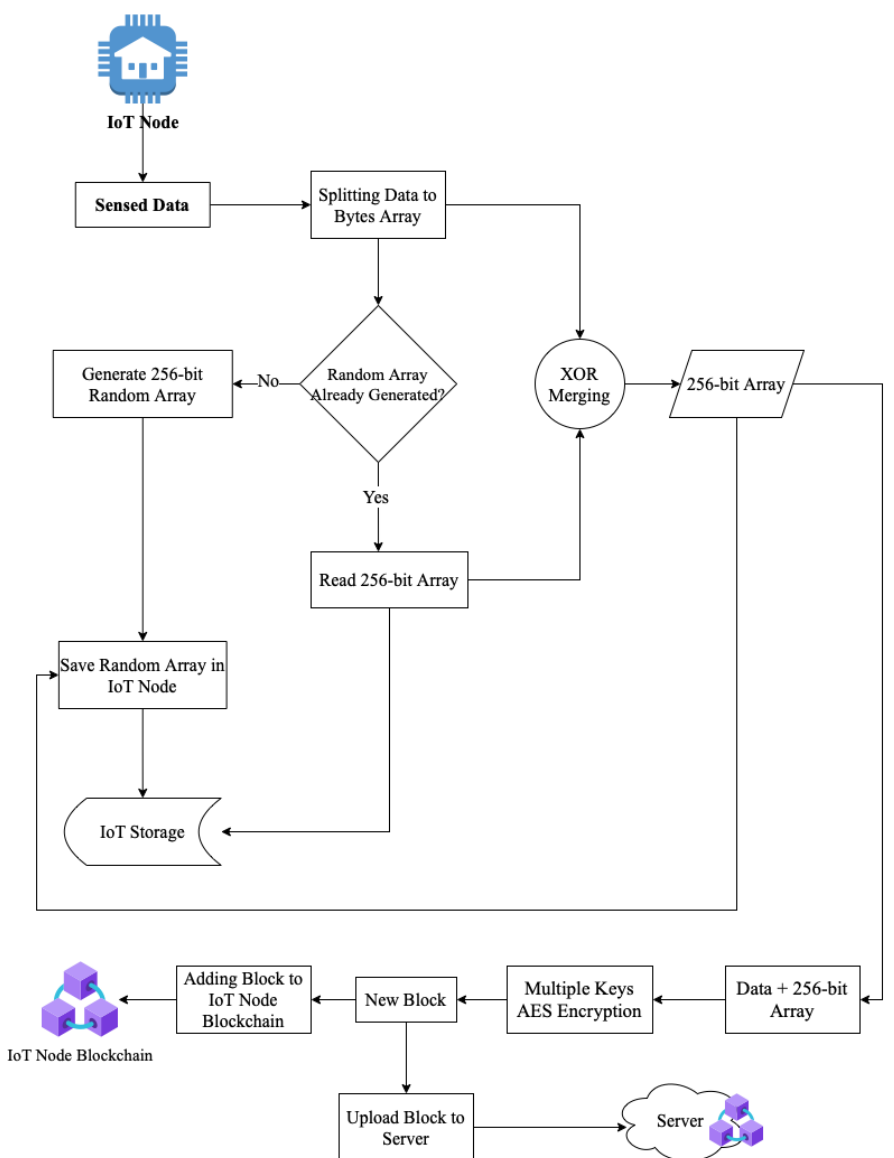
Figure 3. Dynamic blockchain table